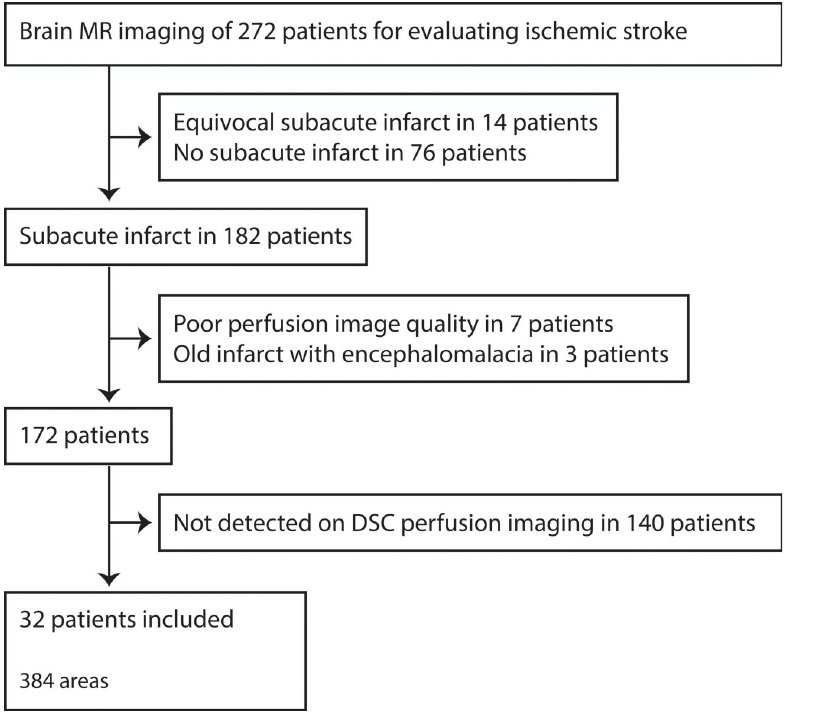
Fig 1. Flow chart of patients included in the